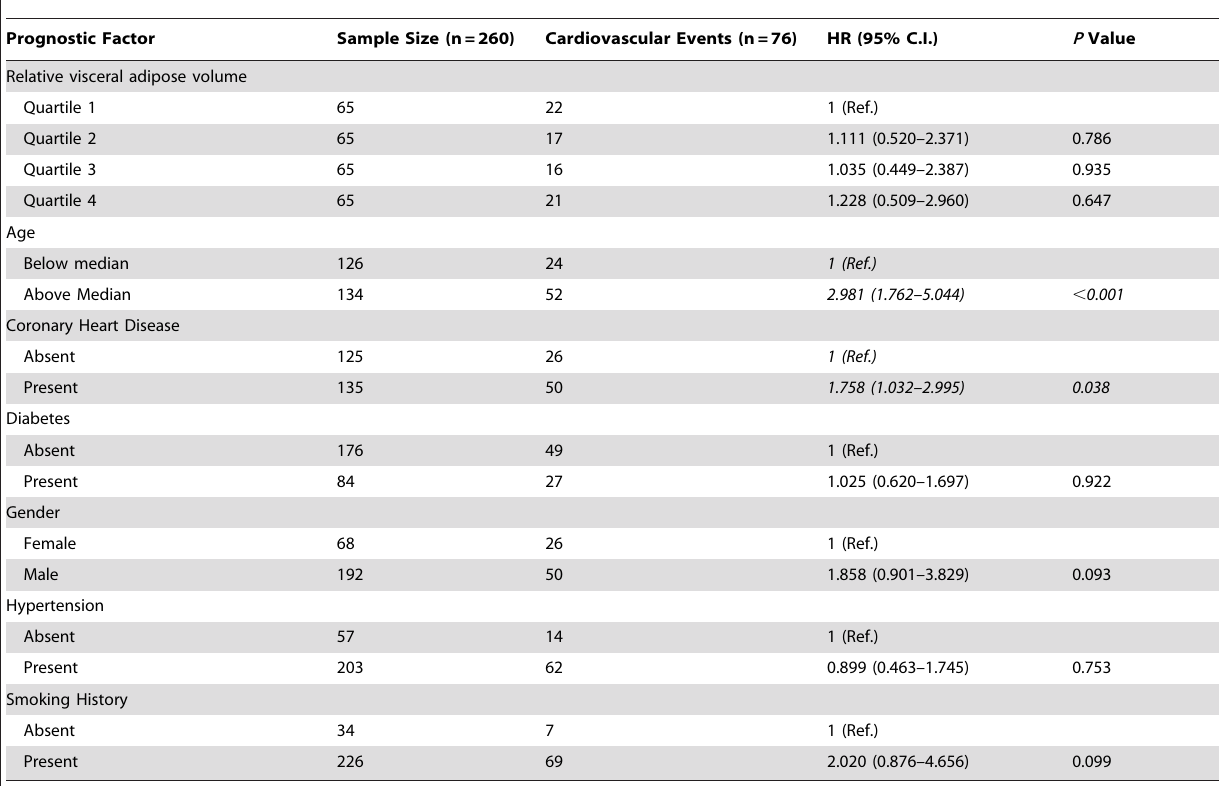
Table 2. Independent determinants of cardiovascular events (myocardial infarction, stroke or death) in patients with